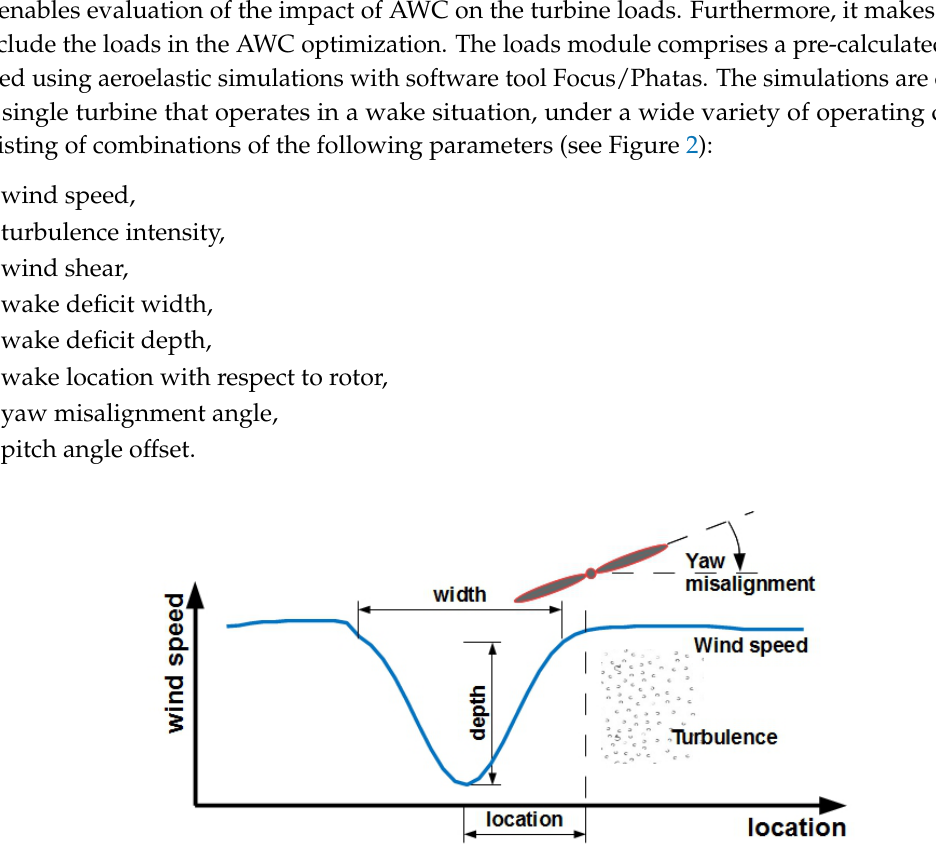
Figure 2. Visualization of the parameters used for describing the wake conditions in front of a